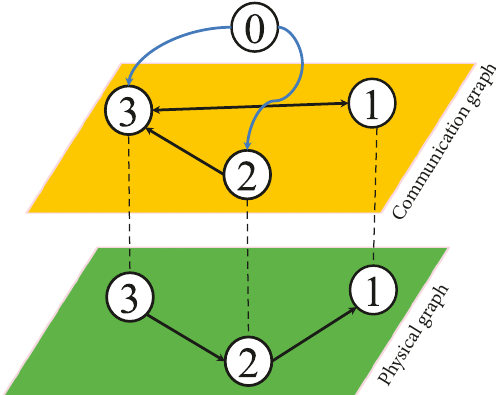
Figure 1: The physical graph G p and communication graph G c for simulation examples. Figure